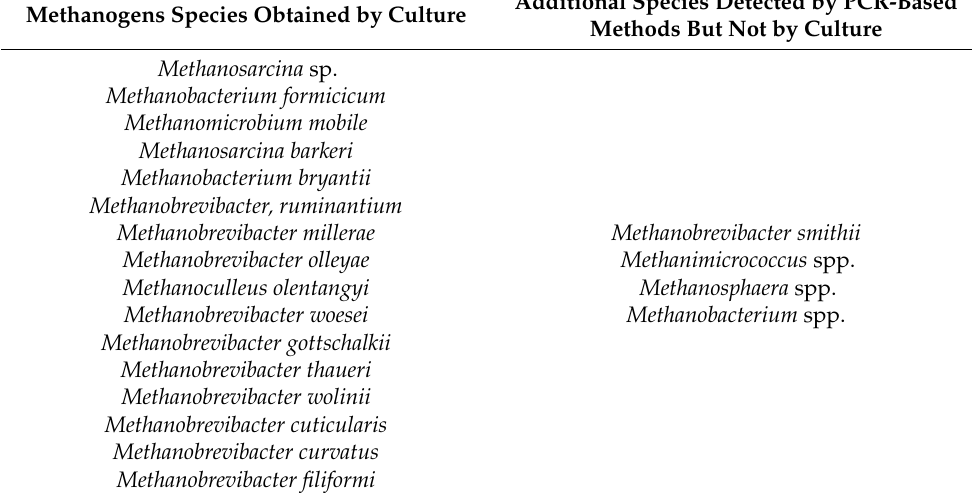
Table 1. Methanogens found in digestive tract microbiota of animals. Additional Species Detected by PCR-Based Methanogens Species Obtained by Culture Methods But Not by Culture Methanosarcina